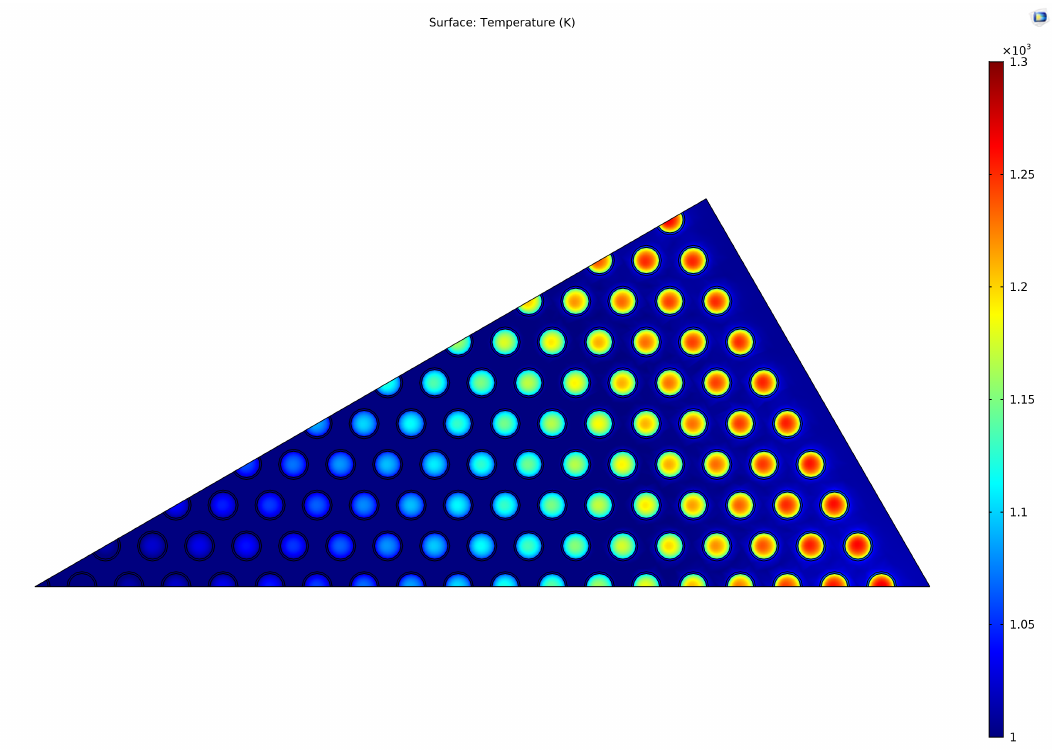
Figure 13. Temperature distribution at the outlet plane.